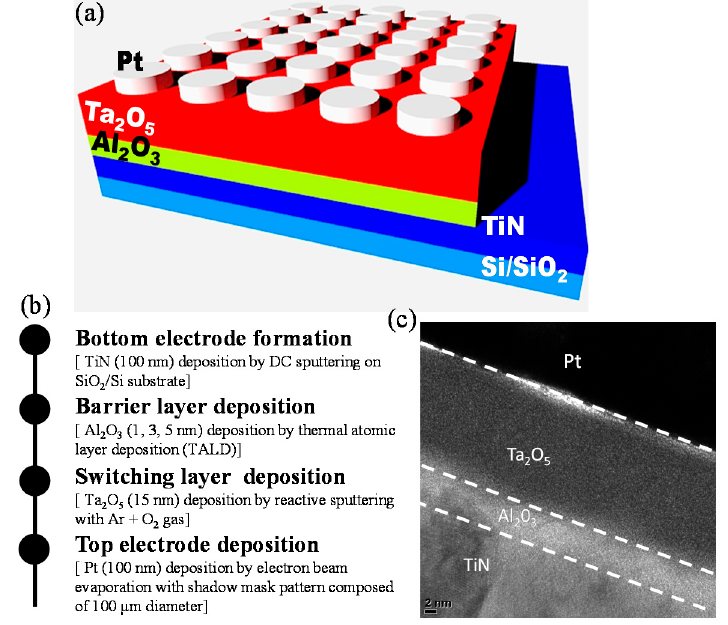
Figure 1. ( a ) Schematic illustration of Pt/Ta 2 O 5 /Al 2 O 3 /TiN device; ( b ) flow chart of device fabrication of the device; ( c ) Cross-sectional transmission electron microscopy (TEM) image of the device.